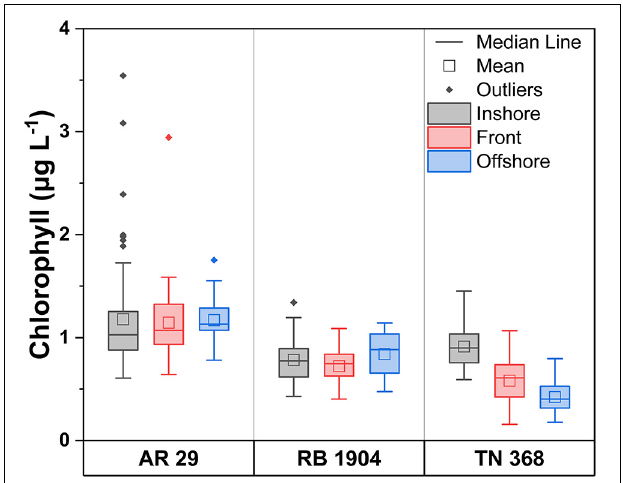
FIGURE 5 | The distribution of chlorophyll at stations inshore of the front, near the front, and offshore of the front within the three cruises. The dots outside of the boxes are extreme values that were not included in the means. Error bars represent the standard